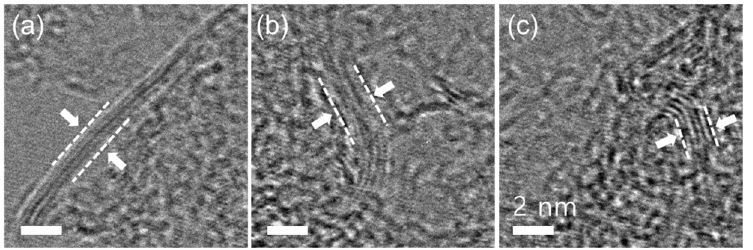
Figure A1. Raman spectrum of the synthesized h-BN at different temperatures: ( a ) 800 °C, ( b ) 900 °C, and ( c ) 1000 °C.